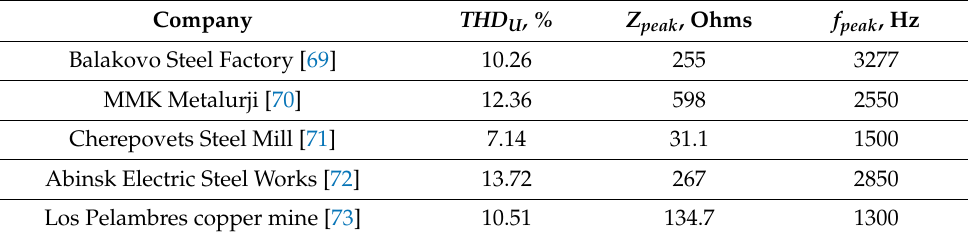
Table 2. Voltage quality indicators in metal plant power supply systems with FC-AFEs and resonant